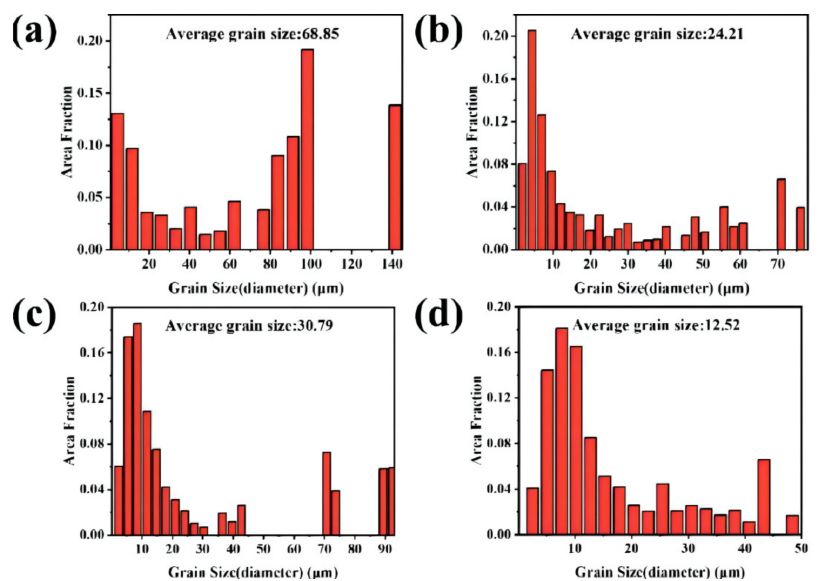
Figure 7. Grain size distribution of: ( a ) initial billet; ( b ) billet deformed by UE; ( c ) Zone V of direct ACAE-forming cabin; ( d ) Zone V of UE + ACAE-forming cabin.